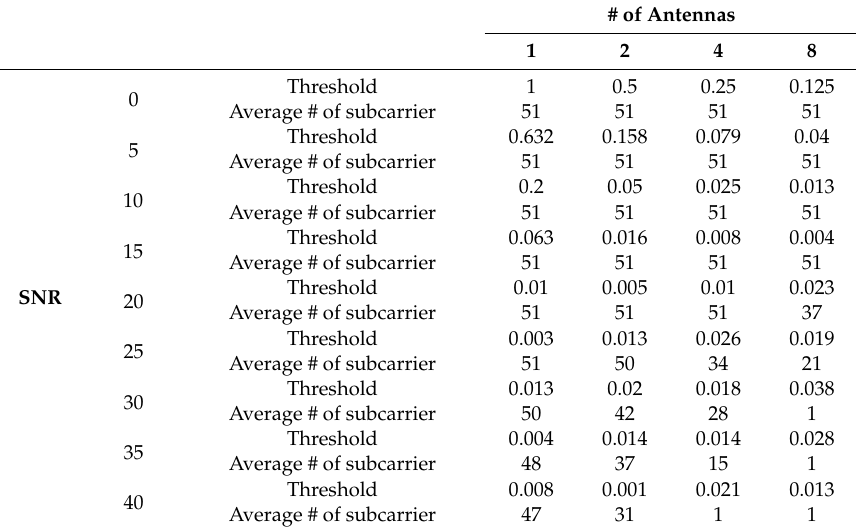
Table 2. Data used in Euclidean distance calculation and optimal threshold for each SNR and number of antennas (TCST